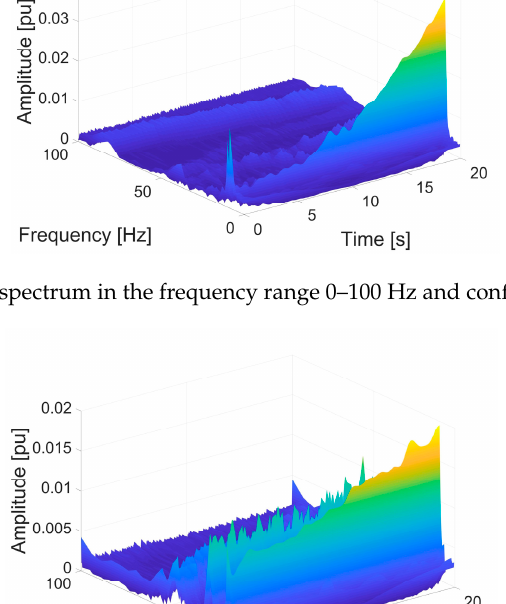
Energies 2020 , 13 , x FOR PEER REVIEW i ′ spectrum in the frequency i ′ spectrum in the frequency Figure 10. Figure 11. Figure 11. i (cid:48) DC spectrum in the frequency range 0–100 Hz and configuration CB. DC DC range (0–100) Hz and configuration CA. range (0–100) Hz and configuration CB.